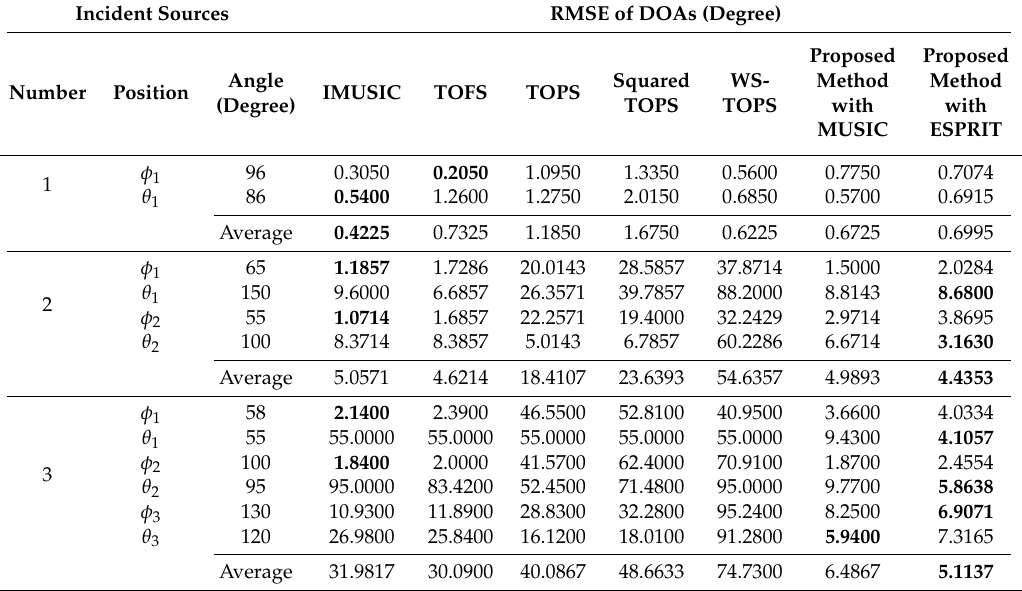
Table 5. Performance evaluation on Experiment 1. The boldfaced results highlight the optimal minimum